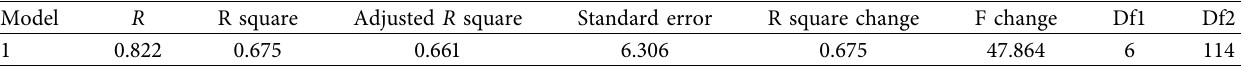
Table 5: Model summary b.